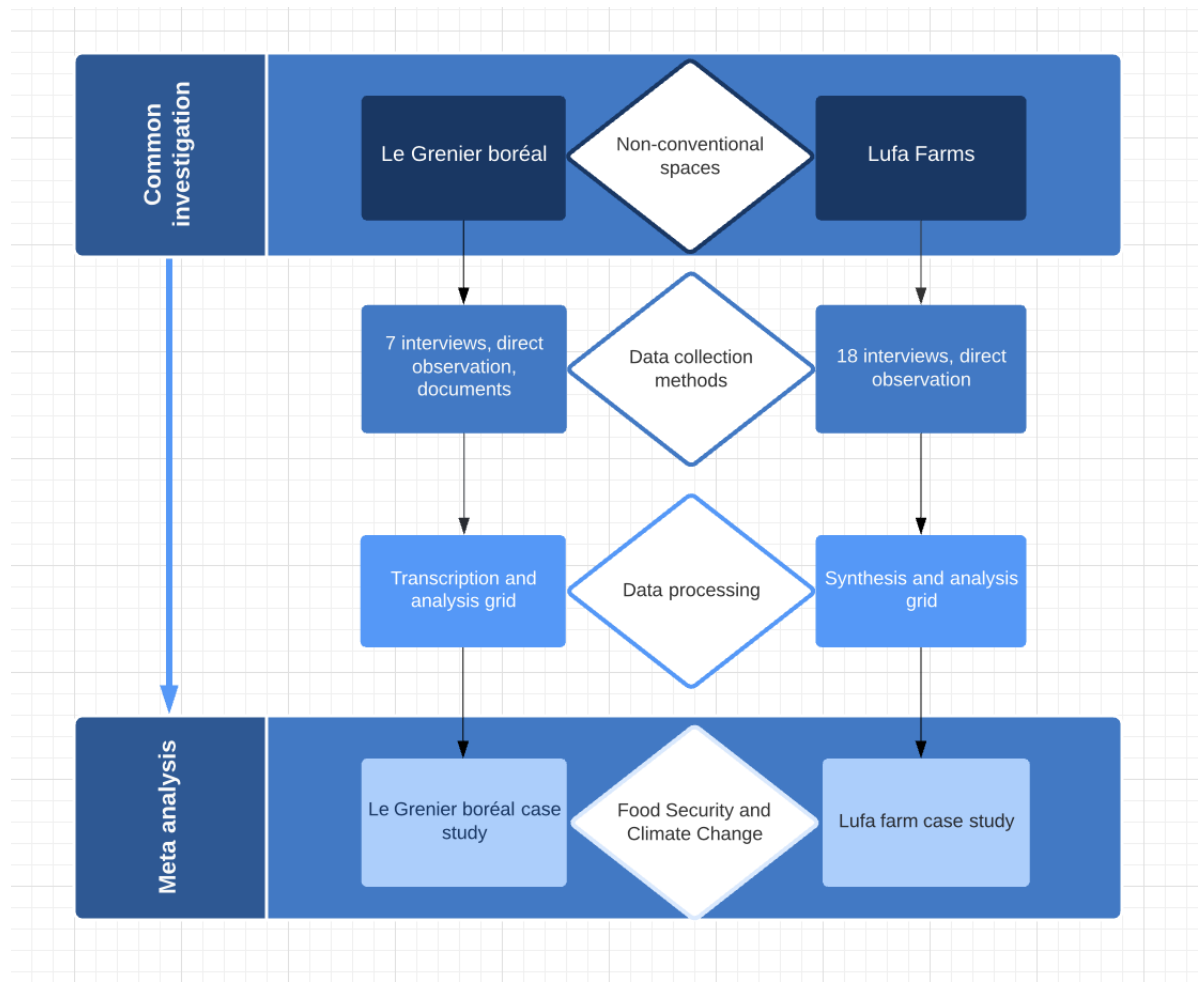
Figure 1. Meta-Analysis Chart .